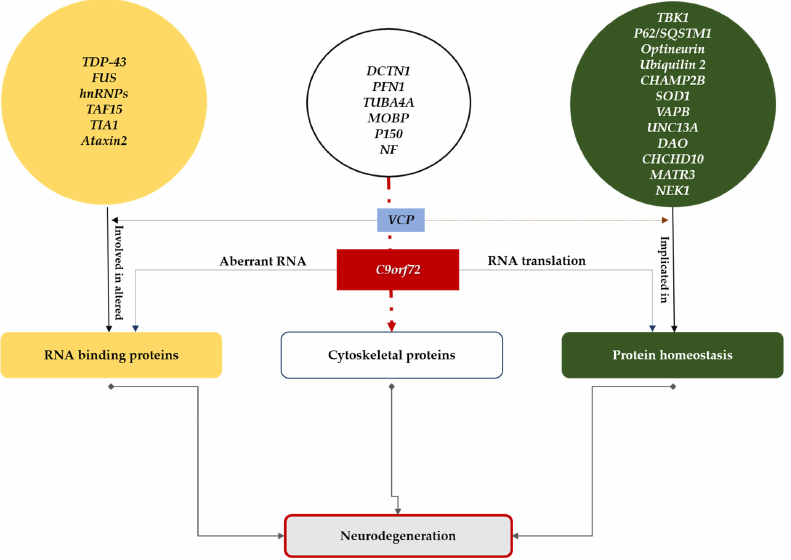
Figure 1. ALS mutations are involved in RNA metabolism, protein degradation, autophagy, or ax- onal transport.